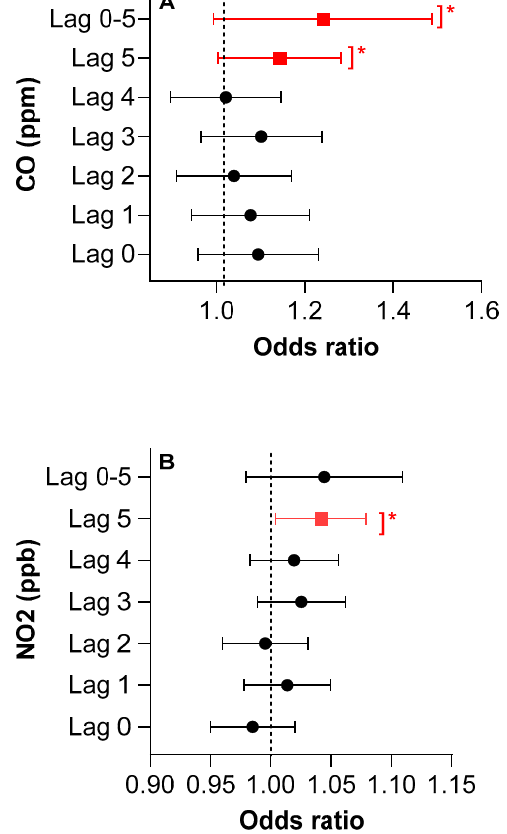
Figure 4. ( A , B ) Odds ratios of an asthma-related ED visit and significant lag days for adults aged 18 and older using a single-pollutant model for CO and NO 2 , adjusted for temperature. Referent time- period is 28 days. * p- value <